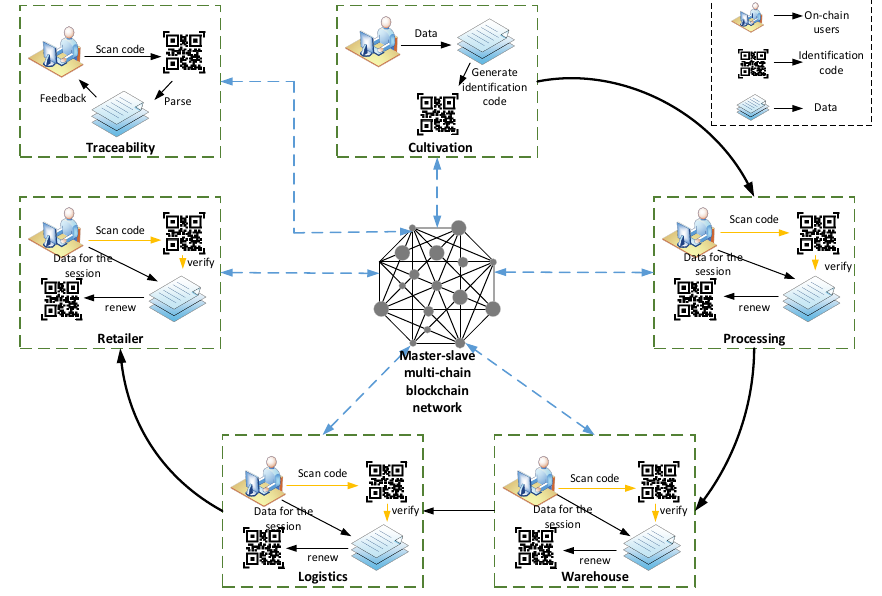
Figure 7. Schematic diagram of the operation process of the system model. The specific flow chart of the relevant data in the system is shown in Figure 8.